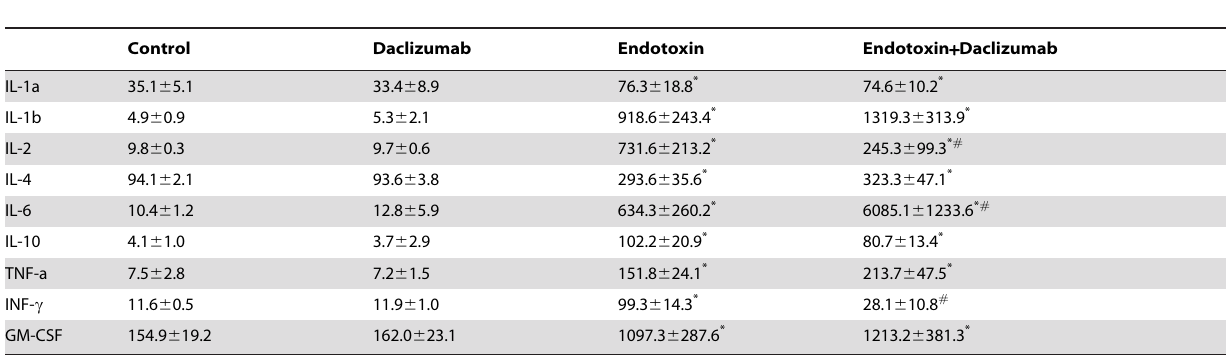
Table 2 . Cytokine concentration in the aqueous humors of the different study groups.